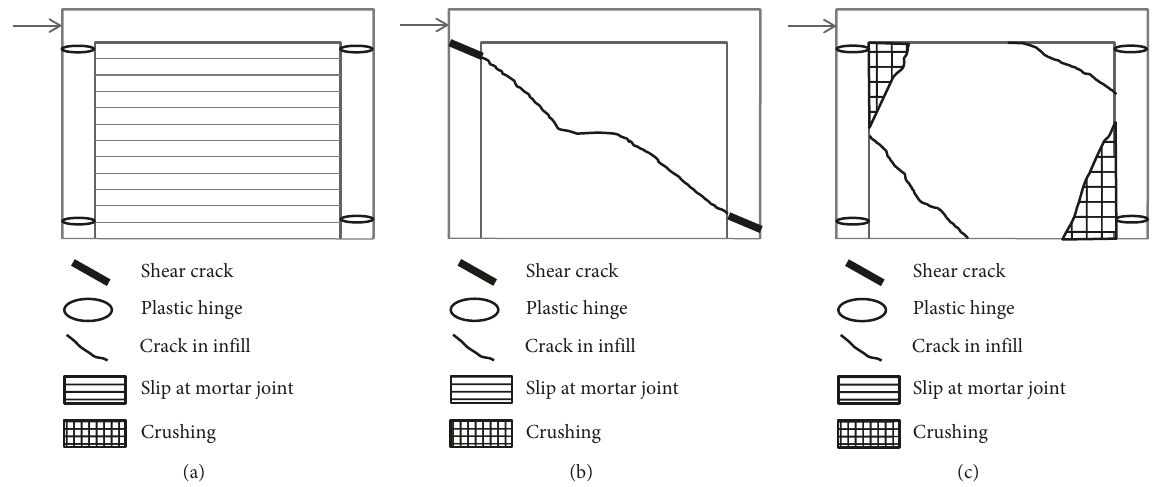
Figure 1: Three distinct failure mechanisms of masonry infills. (a) Horizontal sliding. (b) Diagonal cracking. (c) Panel or corner crushing.